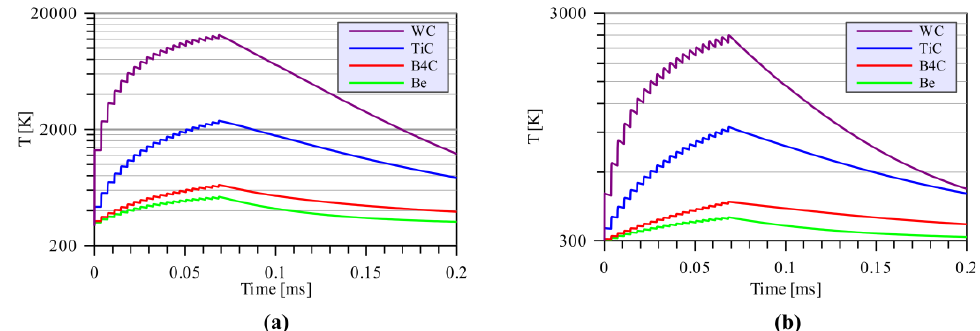
Figure 13. Time evolution of MLL temperature for different multilayer material pairs of WC/SiC, TiC/SiC, B 4 C/SiC and Be/SiC: ( a ) maximum temperature; ( b ) average temperature for a pulse train consisting of 20 pulses with 1 mJ energy per pulse.